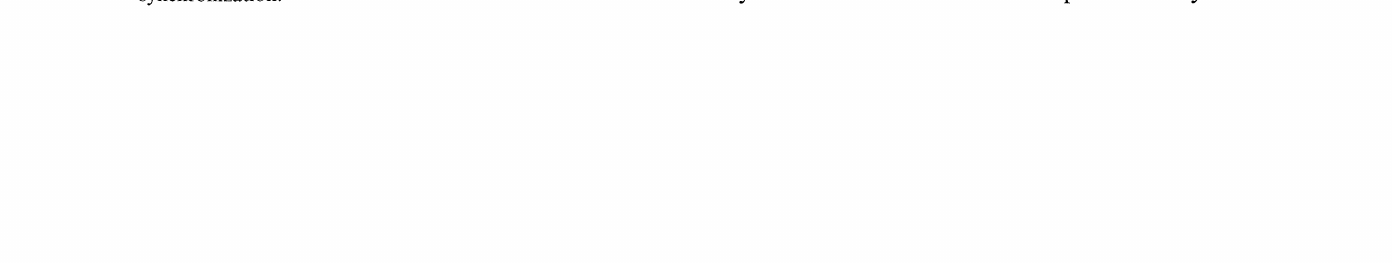
FIGURE 6 A plot of the number of dimensions in both subsystems versus the number of iterations N required for synchronization.